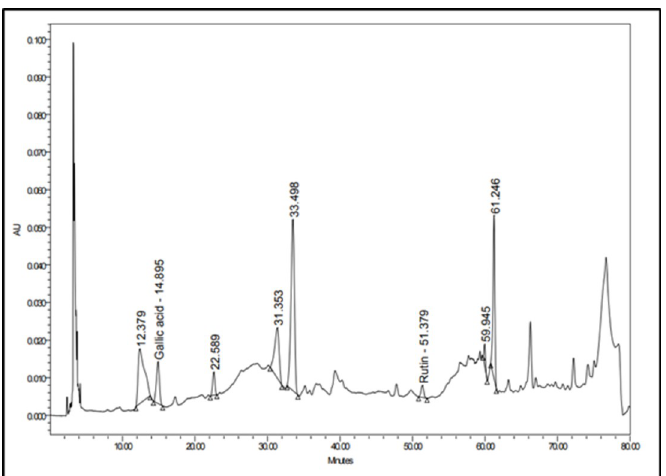
Fig 4. HPLC chromatogram of YC against rutin and gallic acid standards.